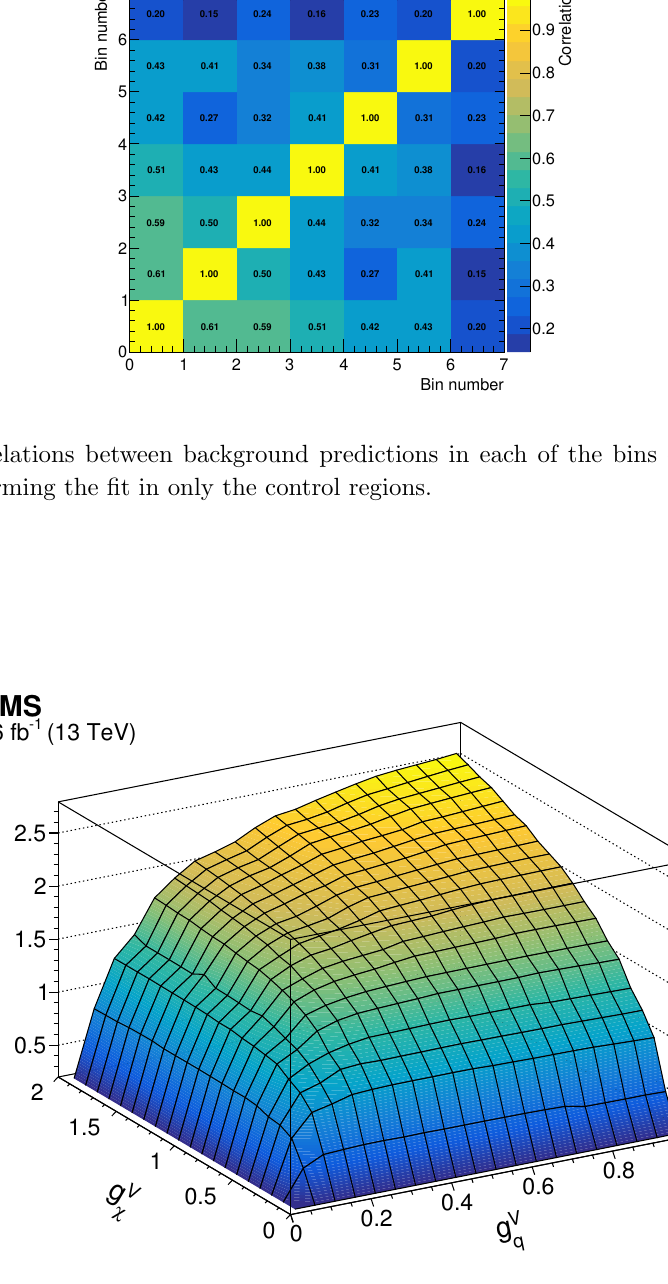
= g A = 0. Masses up to 2.5 TeV are excluded (cid:31) q